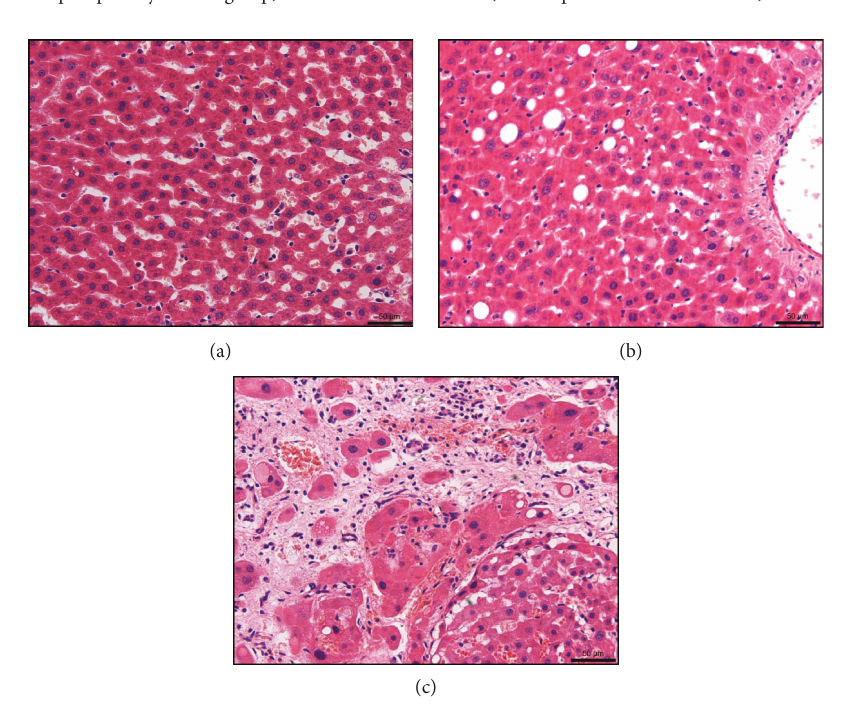
Figure 1: Light micrograph of hepatic histopathology stained with haematoxylin and eosin (magni fi cation, × 200): (a) normal control group; (b) liver injury and treated with phosphatidylcholine group; (c) liver injury